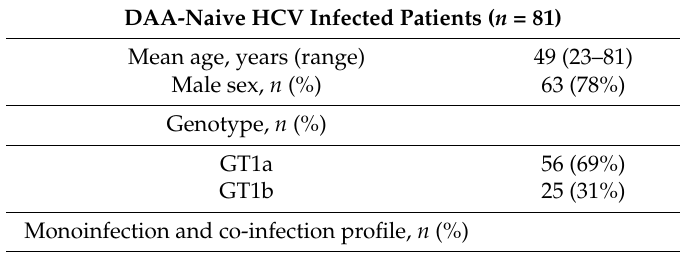
Table 1. Demographic baseline characteristics of the HCV-infected patients and treatment